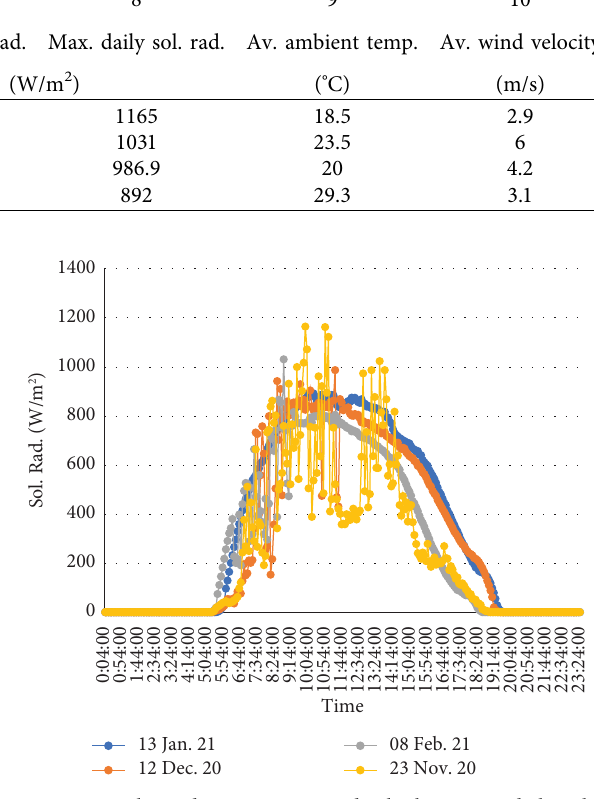
Figure 12: Solar radiation curves under high average daily solar